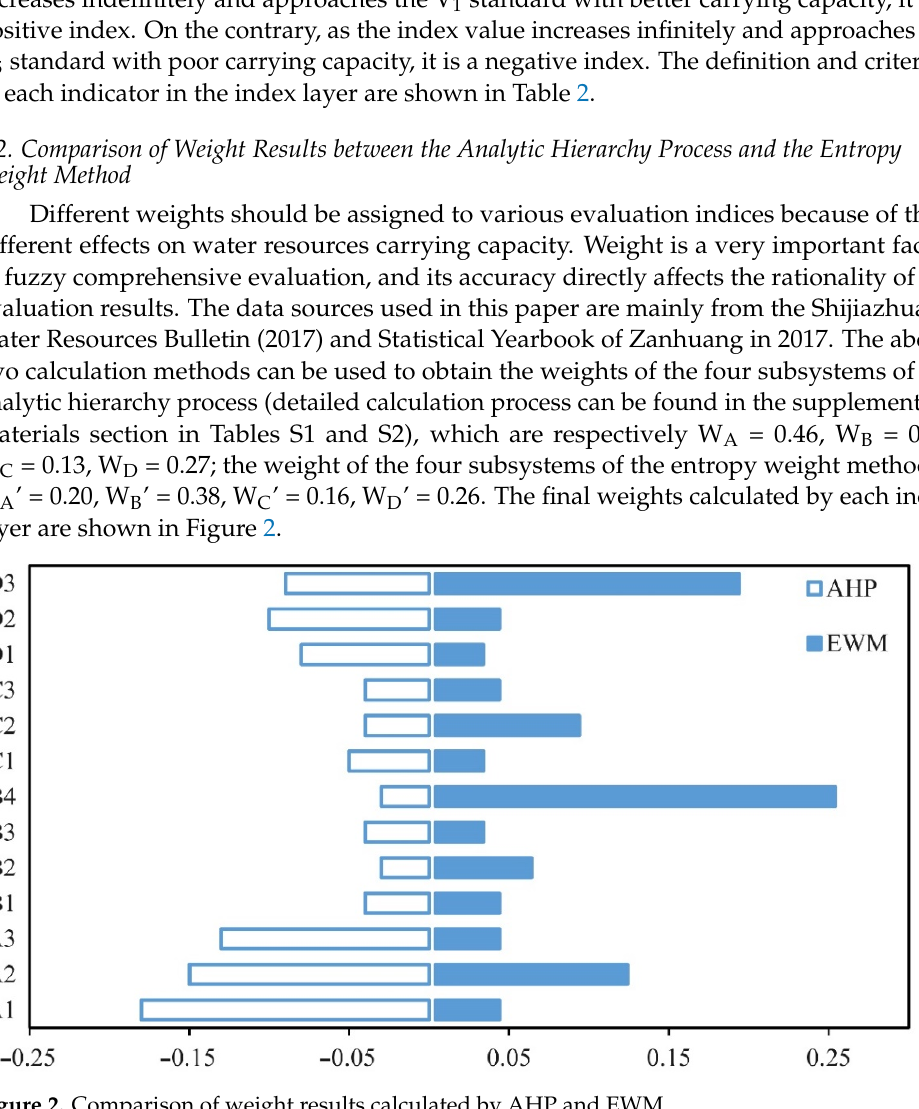
Figure 2. Comparison of weight results calculated by AHP and EWM.